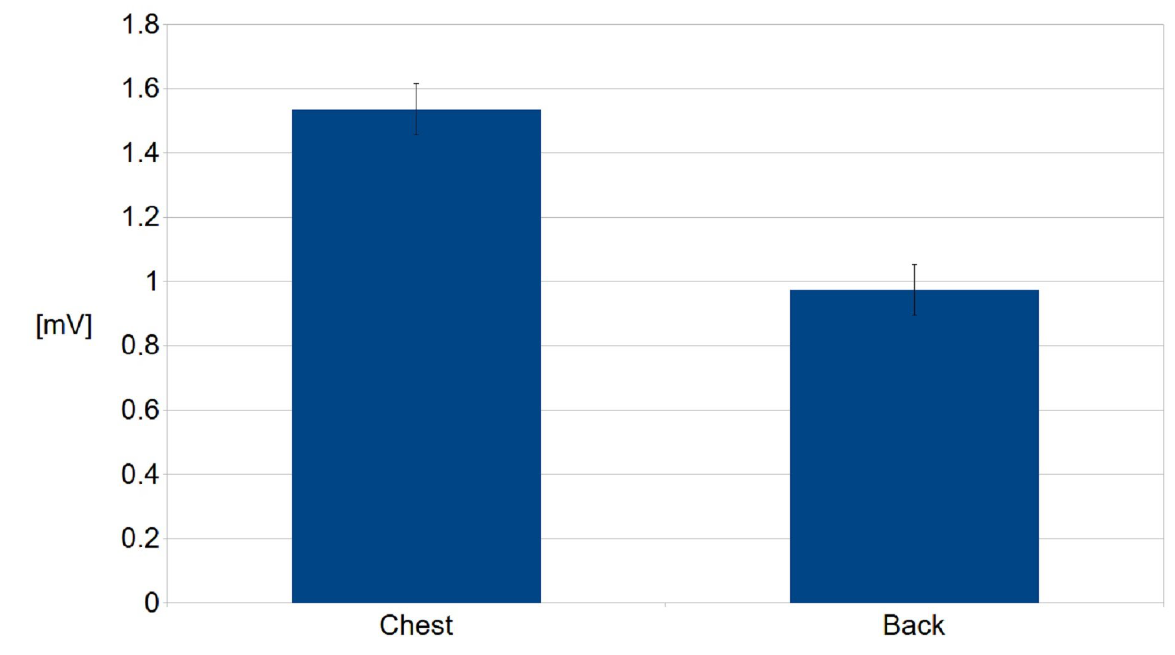
Figure 8. Relation between averaged values of R-wave as measured on the chest and the back using the optimal leads for the whole group of